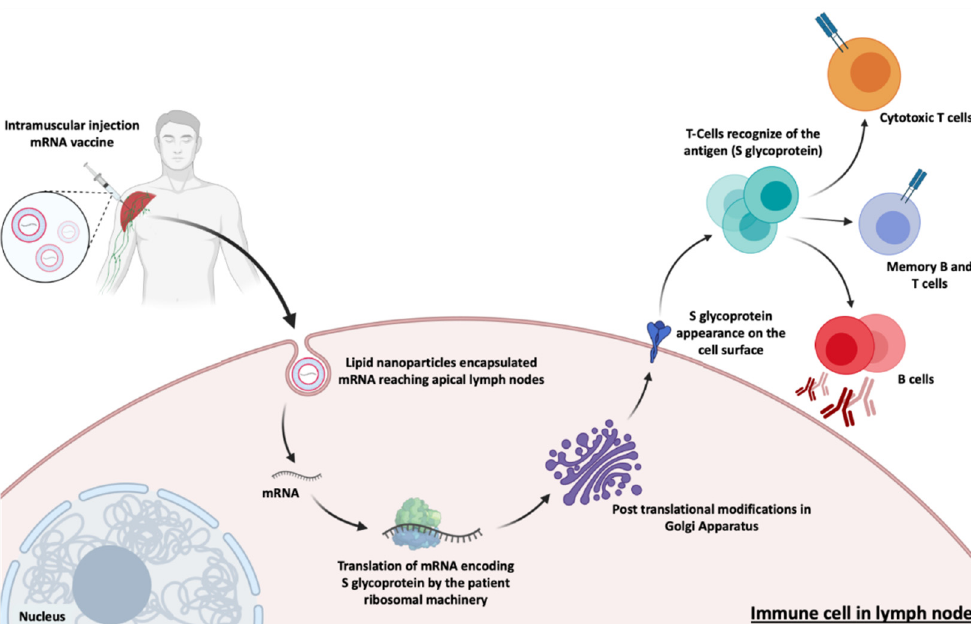
Figure 8. Actuation mechanism of the main mRNA vaccines against SARS-CoV-2. This process begins with the injection, in the patient’s deltoid muscle, of the mRNA usually encapsulated in lipid nanoparticles (LNPs). LNPs loaded with the mRNA encoding the SARS-CoV-2 spike glycoprotein (S), can reach the apical lymph nodes where they transfect dendritic cells. After entry and release of the cell endosome, the mRNA sequence is expressed and post-translational modifications occur. Subsequently, the S glycoprotein is transported and presented in the cell membrane of immune cells (antigen presenting cells). The S glycoproteins incites a specific cytotoxic and humoral immune response, leading to the production of antibodies against SARS-CoV-2, with the aim of achieving immunization against COVID-19.